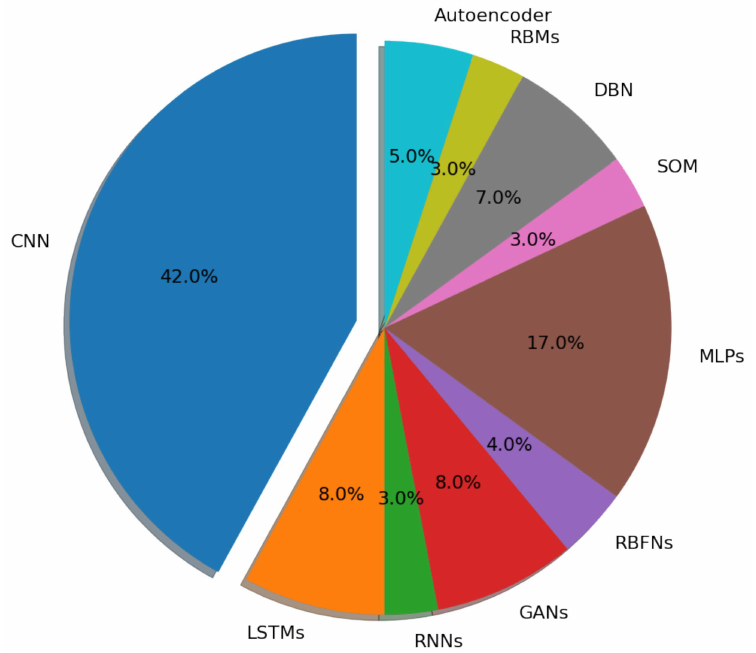
Figure 8. Sector-wise representation of various deep learning models associated with